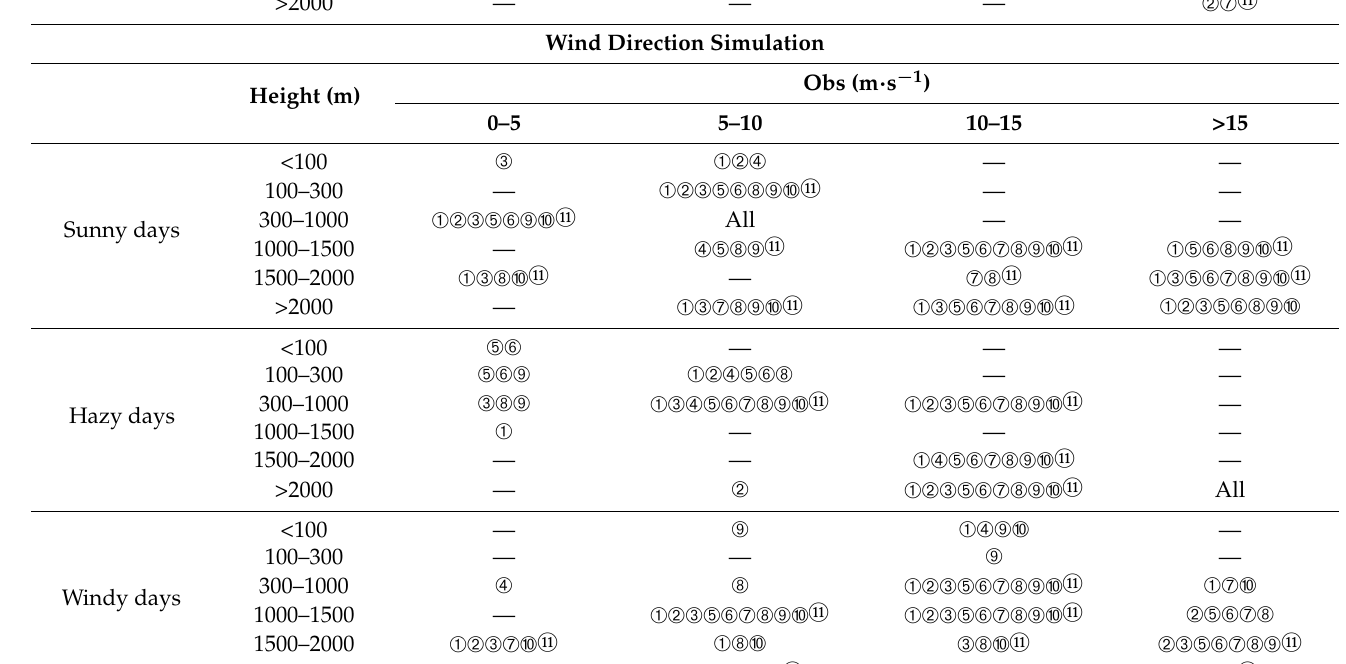
Figure 4. The wind field simulations ( a – f ) with the PBL schemes of YSU, MYJ, QNSE, BouLac, UW and Shin-Hong Schemes and their biases ( g – n ) against the observations. The sunny, haze and windy days were on 24–25 February, 26–27 February and 28 February to 1 March, respectively.